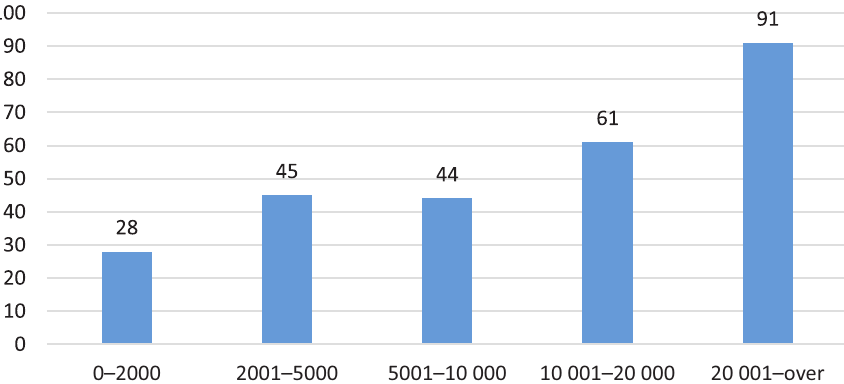
Figure 2. The percentages of municipalities that report that they have a permanent special arrangement—variation be- tween different categories of size. Notes: Percentage; N = 202 planning executives in municipalities; data from